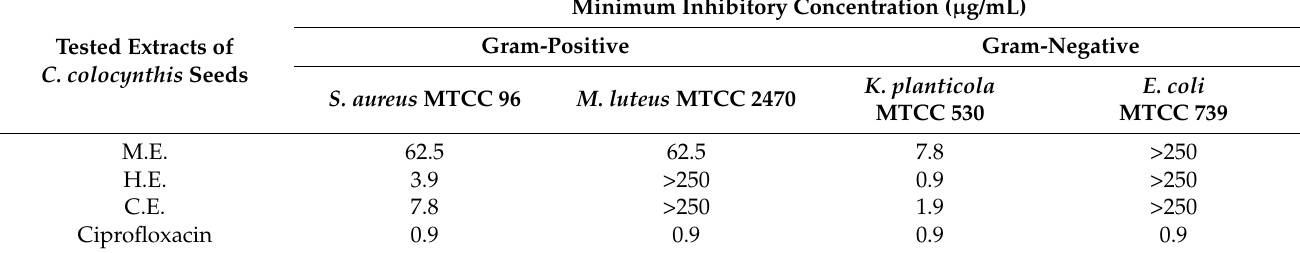
Table 3. Antimicrobial activity of various extracts of C. colocynthis seeds against Gram-positive and Gram-negative